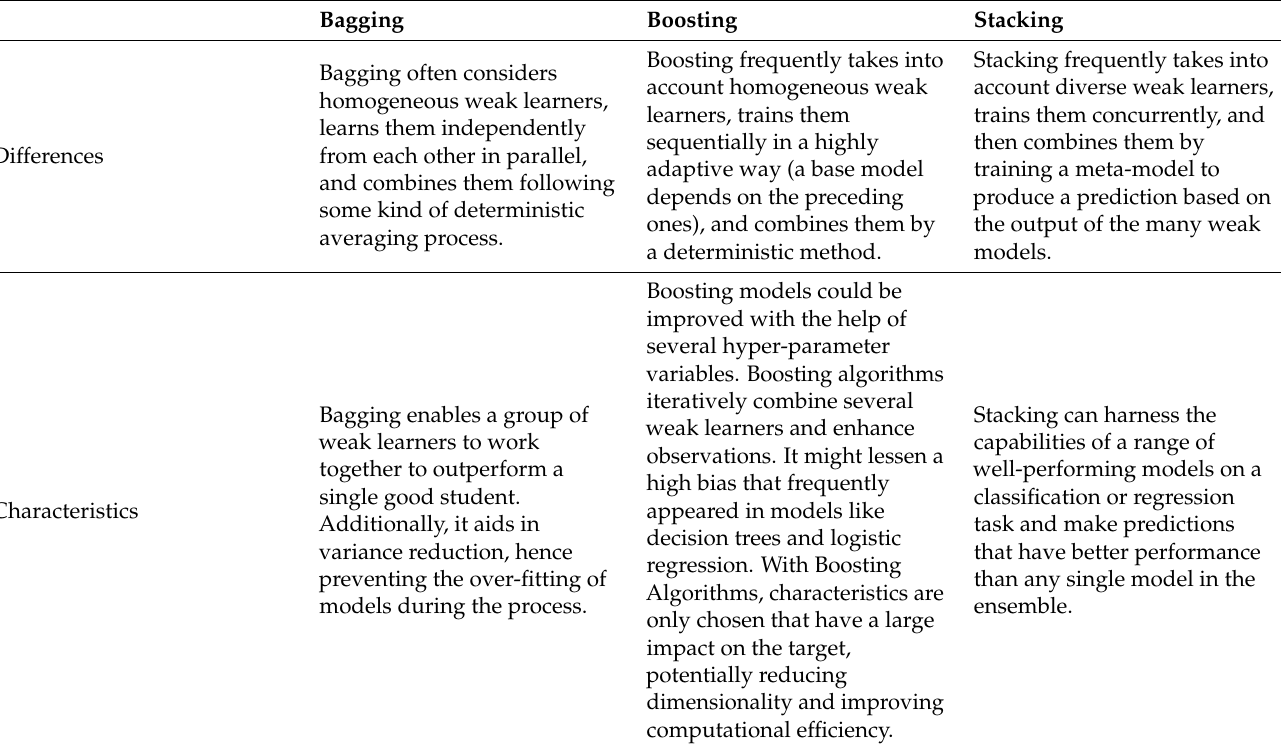
Table 6. A comparison between the differences and characteristics of three ensemble methods (Bagging, Boosting and